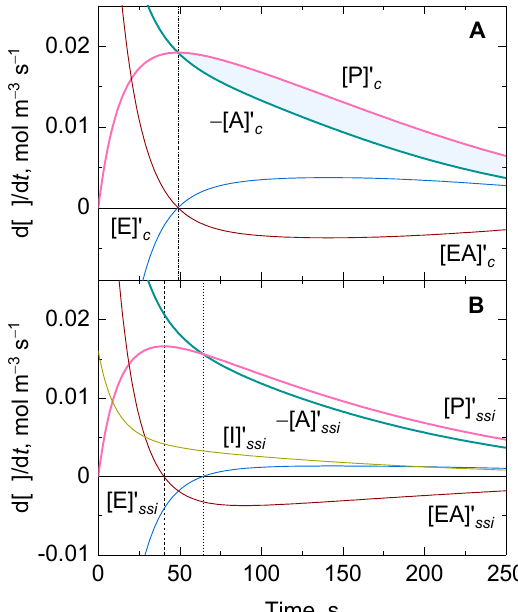
Figure 1. Representative numerical solutions of the time-dependent variation of the reaction rate for the participating compounds of an enzymatic system with one substrate and one substrate–enzyme complex in ( A ) the absence (subscript c ) and ( B ) the presence of one-step suicide substrate inactivation (subscript ssi ) under non-steady-state conditions. Vertical dashed and dotted lines show the time at which [ EA ] (cid:48) and [ E ] (cid:48) are equal to zero, respectively. The shadowed area between − [ A ] (cid:48) and [ P ] (cid:48) in ( A ) shows the gap that should be closed between these two rates to reach the steady state. Initial = 4 mol · m − 3 , [ E ] = 2 mol · m − 3 , k a = 10 − 2 m 3 · ( mol · s ) − 1 , k = 5 × 10 − 3 s − 1 conditions: [ A ] b 0 0